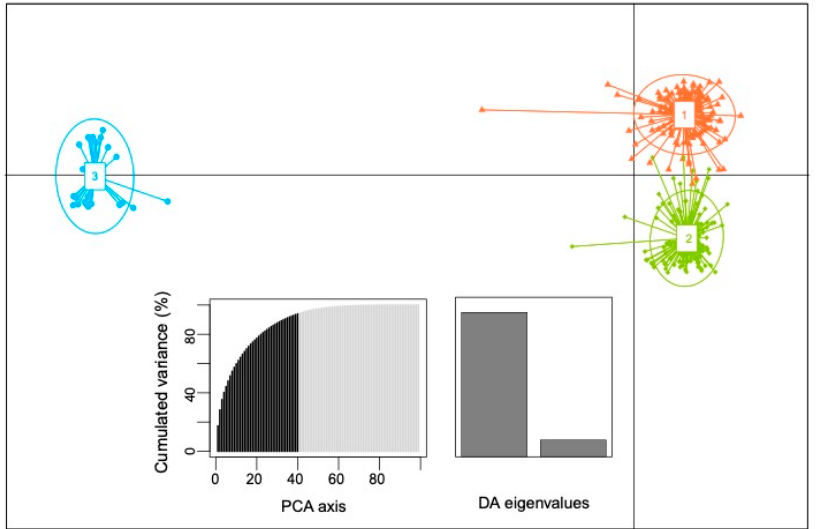
Figure 4. A discriminant analysis of principle components (DAPC) scatter plot of the 365 accessions of Thai rice landraces. The x and y axes represent the discriminant functions one and two, respectively. Dots represent the individual samples, and centroids are indicated with numbers (1–3). The inset bar charts indicate the number of principle components retained by DAPC (right) and the cumulative variation (left).